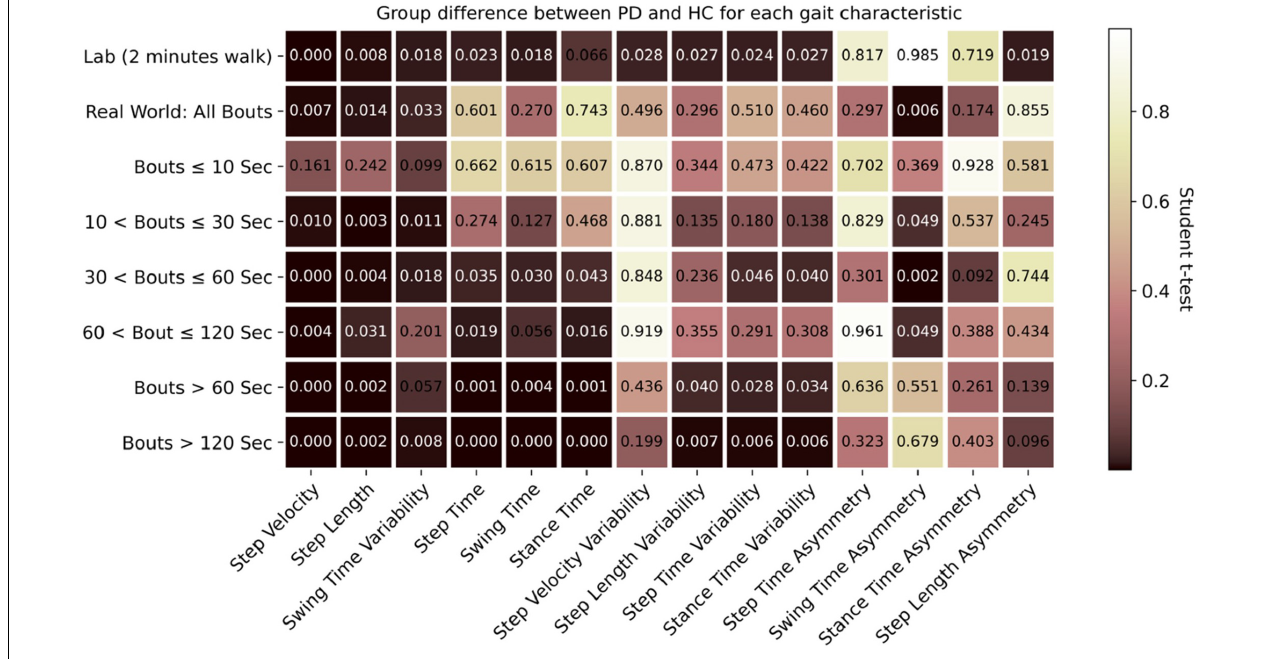
FIGURE 4 | Comparison of effect of environment (lab vs. real-world) and WB duration (threshold) on discrimination between PD and HC participants (Dark highlighted color means lower p